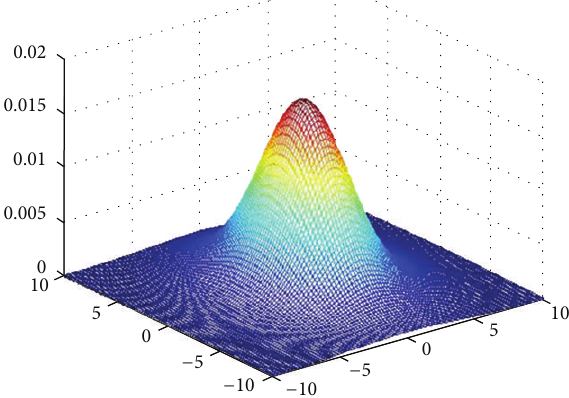
Figure 16: The pdf of a bivariate Gaussian mixture model for sample parameters and its marginal